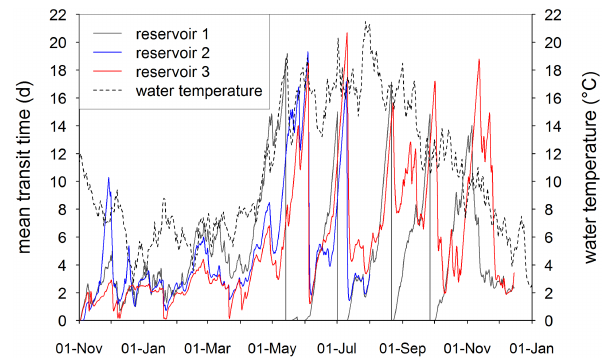
Figure 5. Mean transit time of the water inside the in-stream reser- voirs and the temperature of the ditch water directly downstream of the